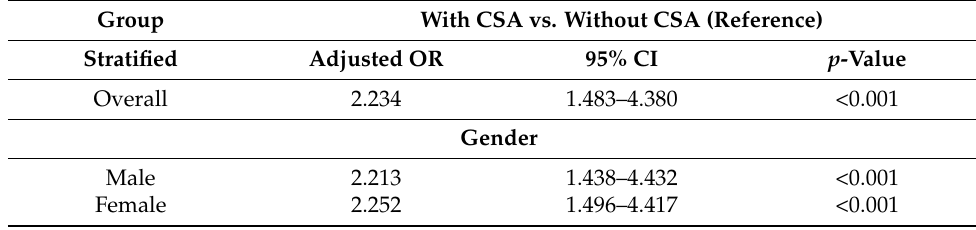
Table 3. Factors of obesity stratified by variables using logistic